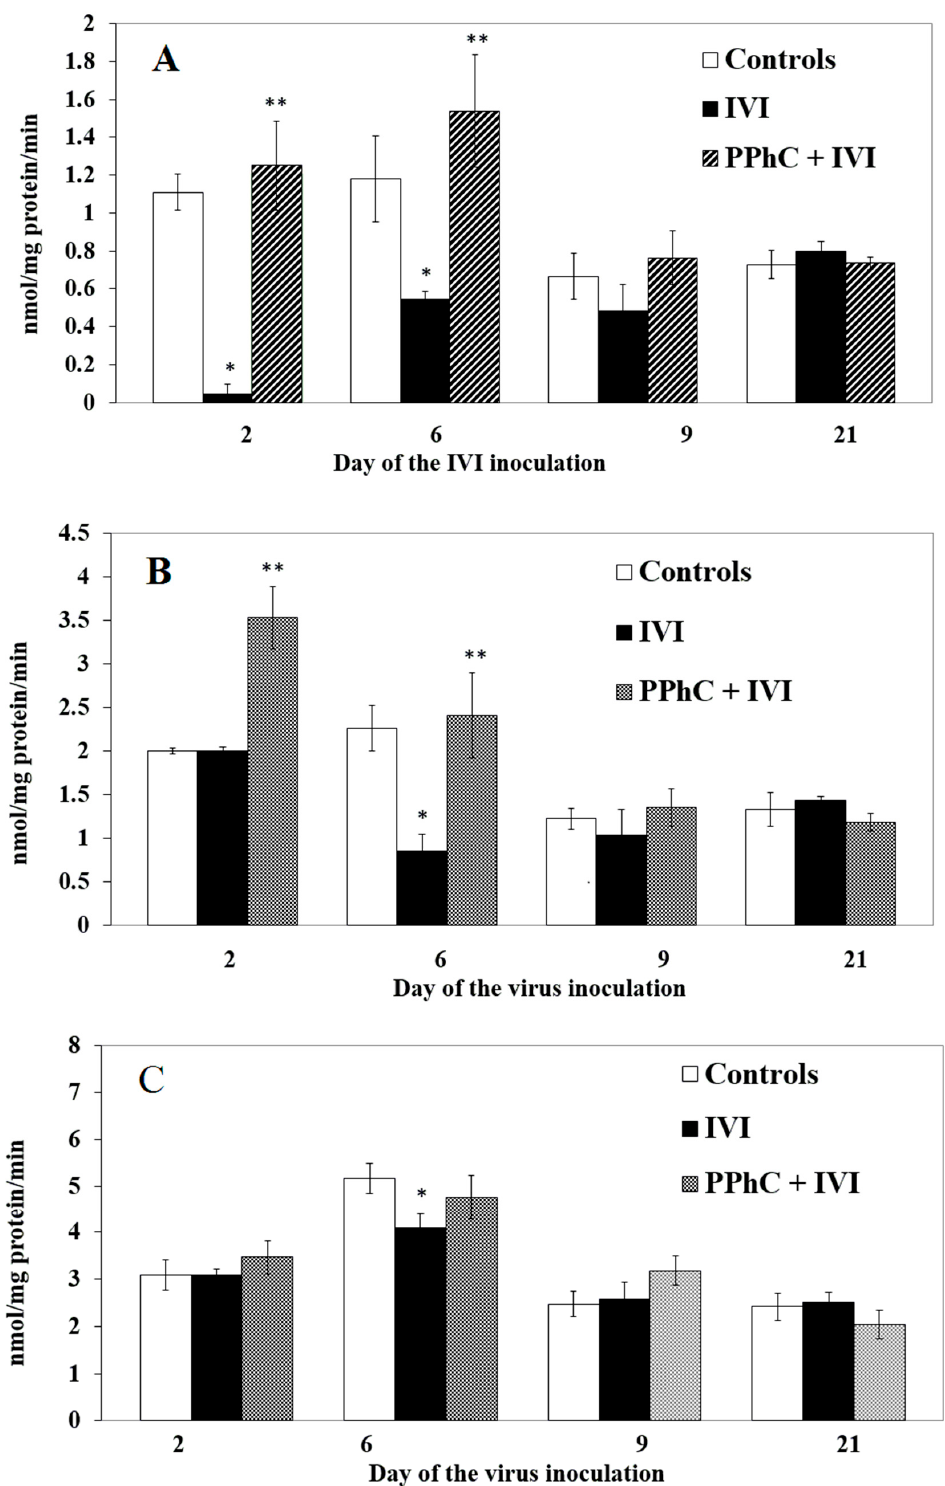
Figure 4. Panel of liver enzyme of monooxygenase N-demethylase (EMND) ( A ), APND ( B ), and ANND ( C ) activities characterizing the effect of PPhC in IVI-infected mice. Statistical significance ( p < 0.05) between the mean healthy group’s enzymatic activities vs. IVI models is indicated via the asterisk (*), and between the mean IVI group’s enzymatic activities vs. those treated with the PPhC IVI groups is indicated via a double asterisk (**).